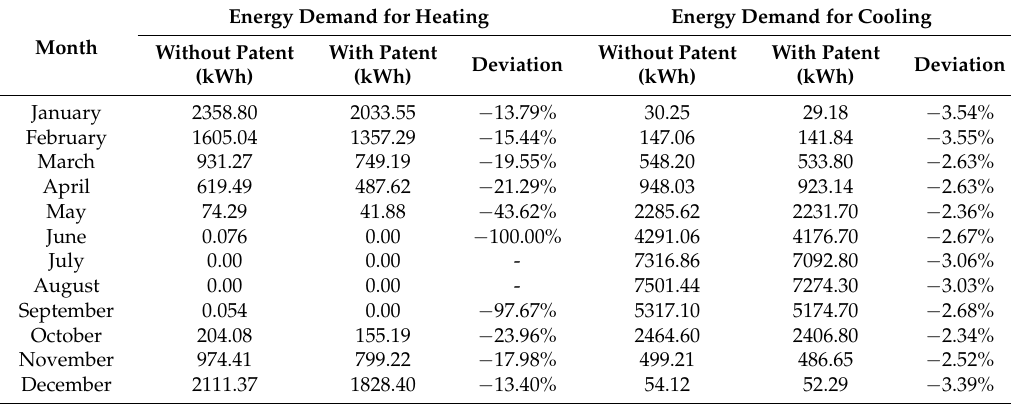
Figure 10. Monthly energy demand of the building for the different scenarios considered. The heating energy demand is represented by the red line, and the cooling energy demand by the blue line. Table 5. Differential of energy demand between the case study without patent and the one with patent for the current period.